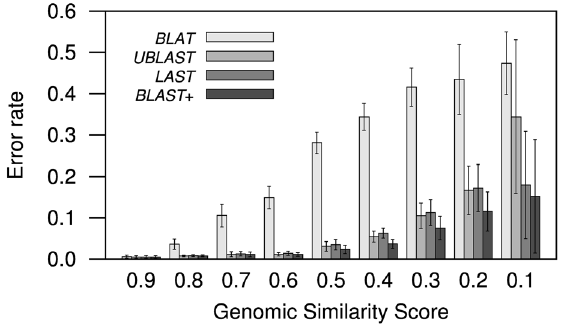
Figure 4. Error rate estimated using conservation of gene order. The estimate consists on false negatives (a paralog conserved next to a RBH) divided by the sum of false negatives + true positives (RBHs showing conservation of gene order). BLAST consistently showed the lowest error rates. Both LAST and UBLAST showed the most similar error rates to those produced by BLAST except when the genomes compared had low GSS , where UBLAST had higher error rates than LAST. BLAT showed the highest error rates. See Note in Figure